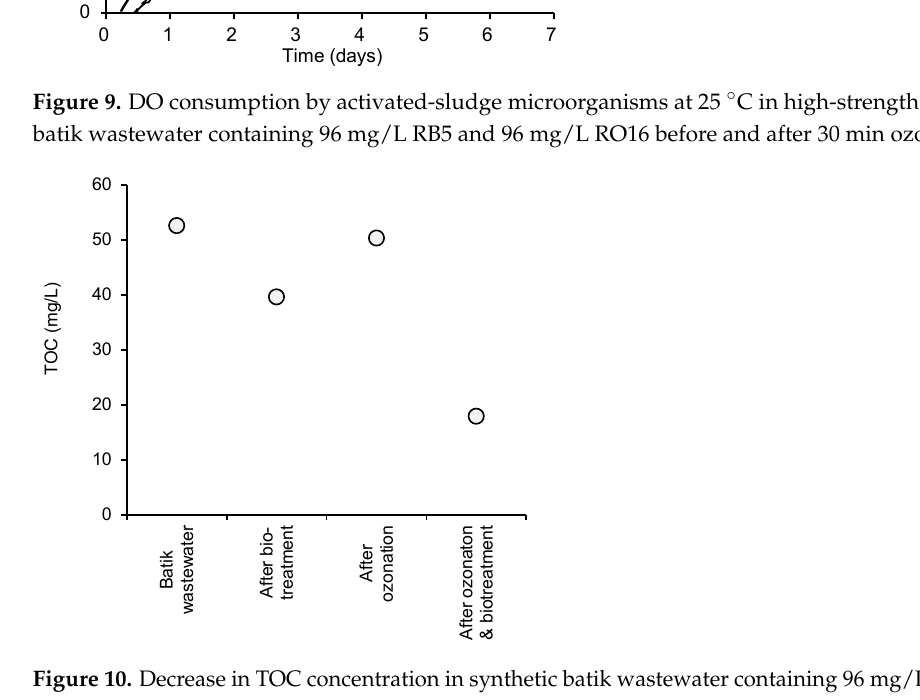
wastewater. The BOD 5 for the high-strength wastewater after 30 min ozonation was found to be 15.4 mg/L.